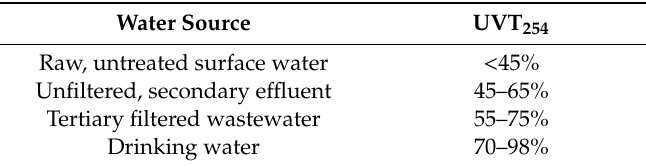
Table 10. General ranges of UVT 254 for various water sources. Used with permission of John Wiley & Sons.